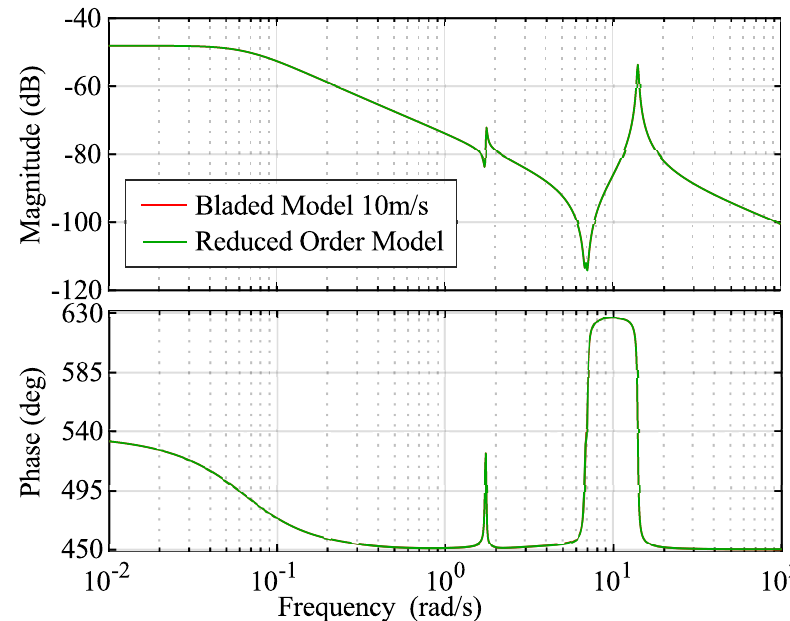
Figure 5. Frequency response of Bladed and reduced–order models in mode 2.